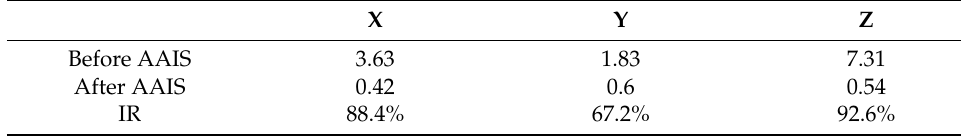
Table 5. The standard deviation (nT) in the static experiment.